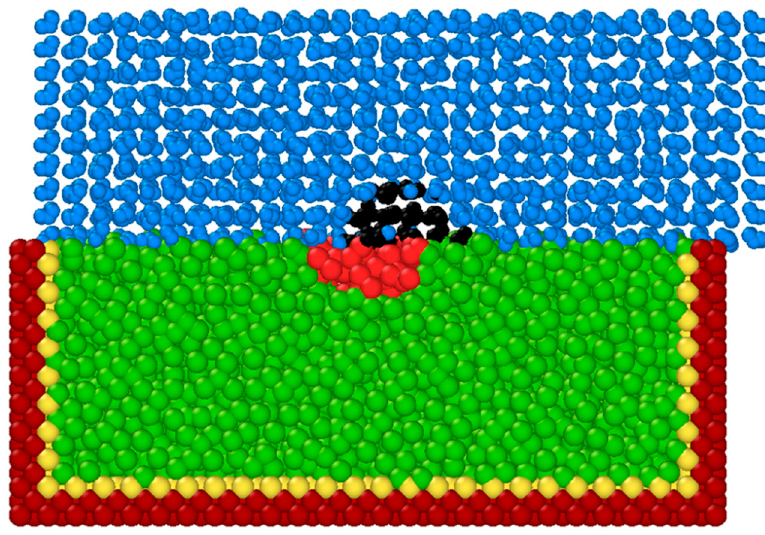
Figure 12. MD Simulation Snapshot of Cavity Machined during the LA-LBMM Process (Dynamic Mode).